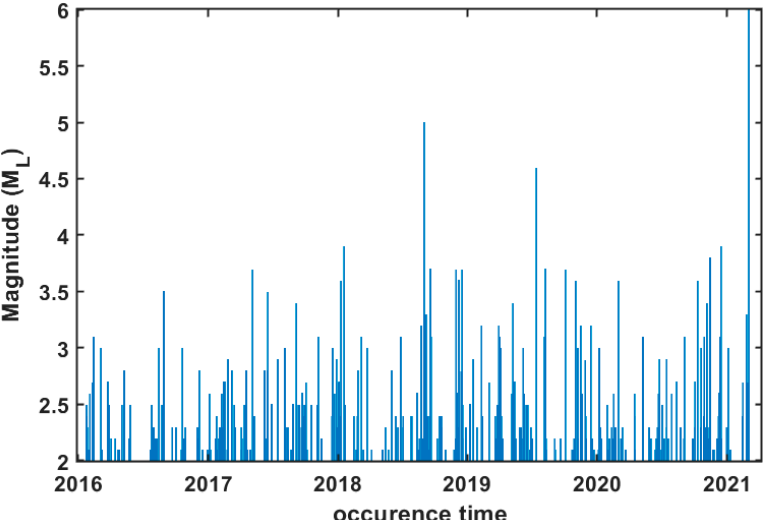
Figure 4. Time–Magnitude plot for a radius R = 80 km around the epicenter and a magnitude threshold, M th = 2.0.